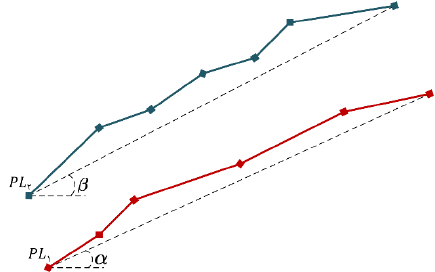
Figure 7. Orientation difference between two linear objects.